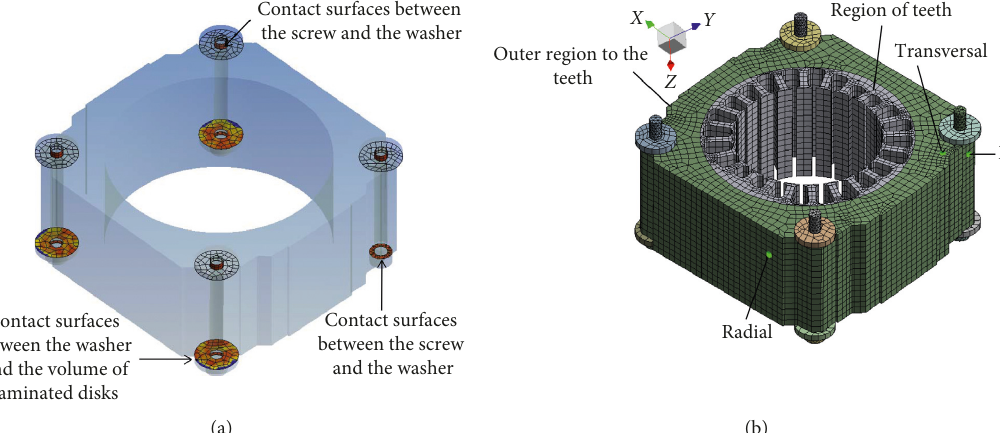
Figure 5: (a) Specification of contact regions between stator components for both models and (b) simplified numerical stator